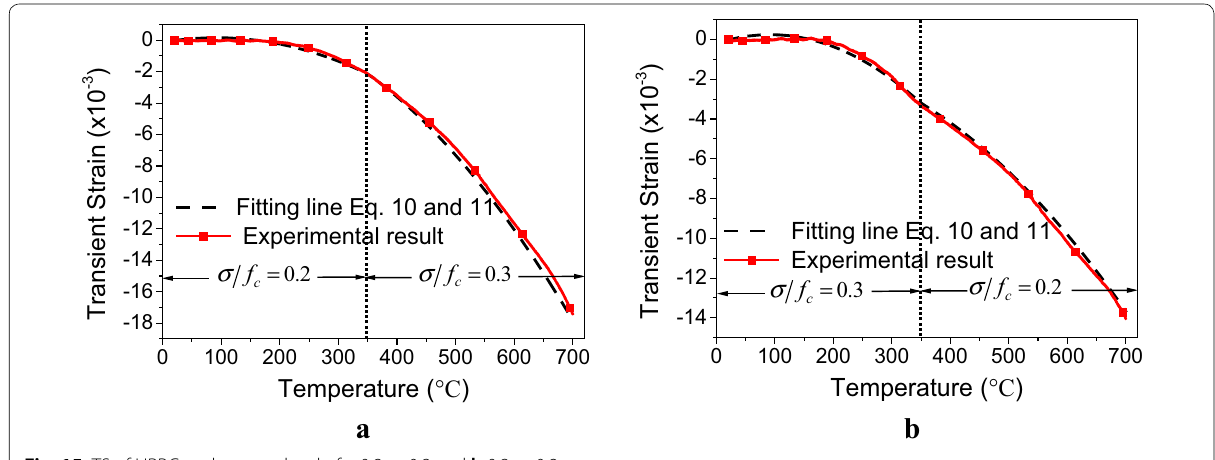
Fig. 15 TS of HRPC under stress level of a 0.2 to 0.3 and b 0.3 to 0.2.